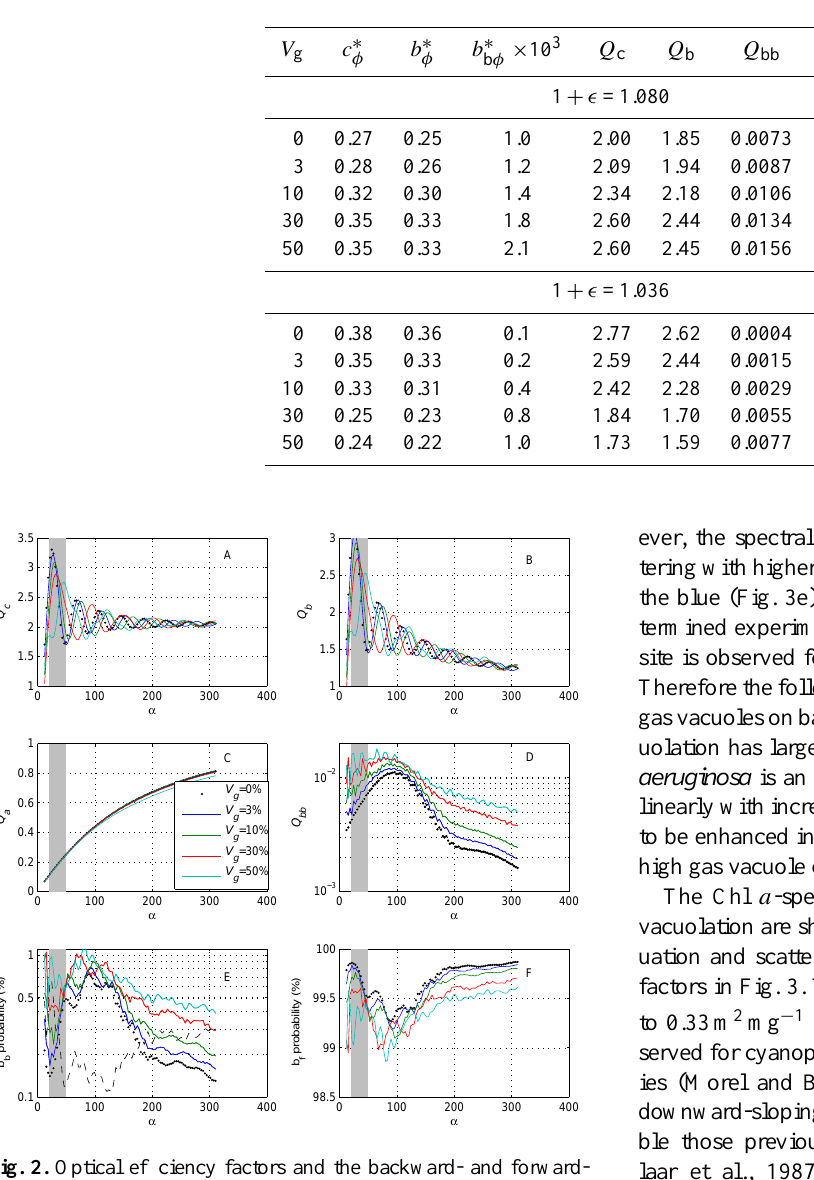
Table 2. Chl a -specific volume coefficients (m 2 mg − 1 ), efficiency factors, and scattering ratios (%) at 510nm for a population of M. aerugi- nosa modelled as two-layered spheres with variable gas vacuole content (%) for shell layers 1 + (cid:15) = 1 . 080 and 1 + (cid:15) = 1 . 036.